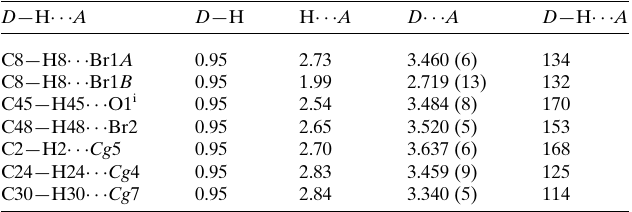
Figure 4 Part of the 1 H NMR spectrum of the hydride bridging absorbing at (cid:5) 4.55 ppm.